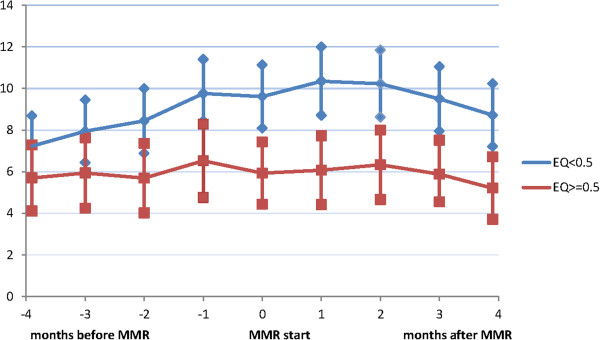
Net sick leave days four month before until four month after multimodal rehabilitation (MMR)start. Mean net sick leave days four month before until four month after MMR start in patients with EQ-5D < 0.5 (n = 253 ) respectively ≥0.5 (n = 153 ) at MMR start. 95% confidence interval (CI).